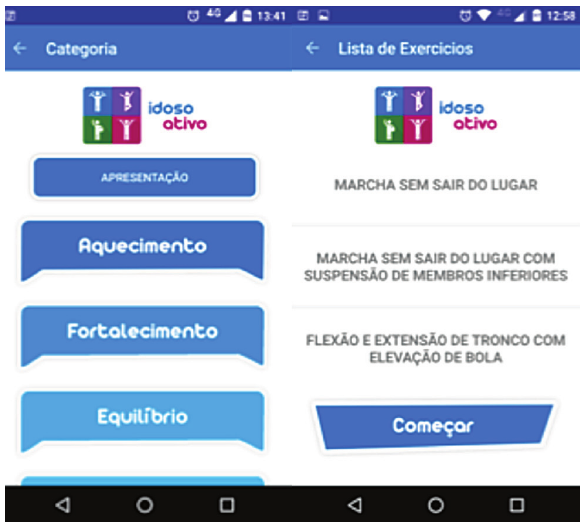
Figure 3 - Presentation for the selection of modalities and exercises.